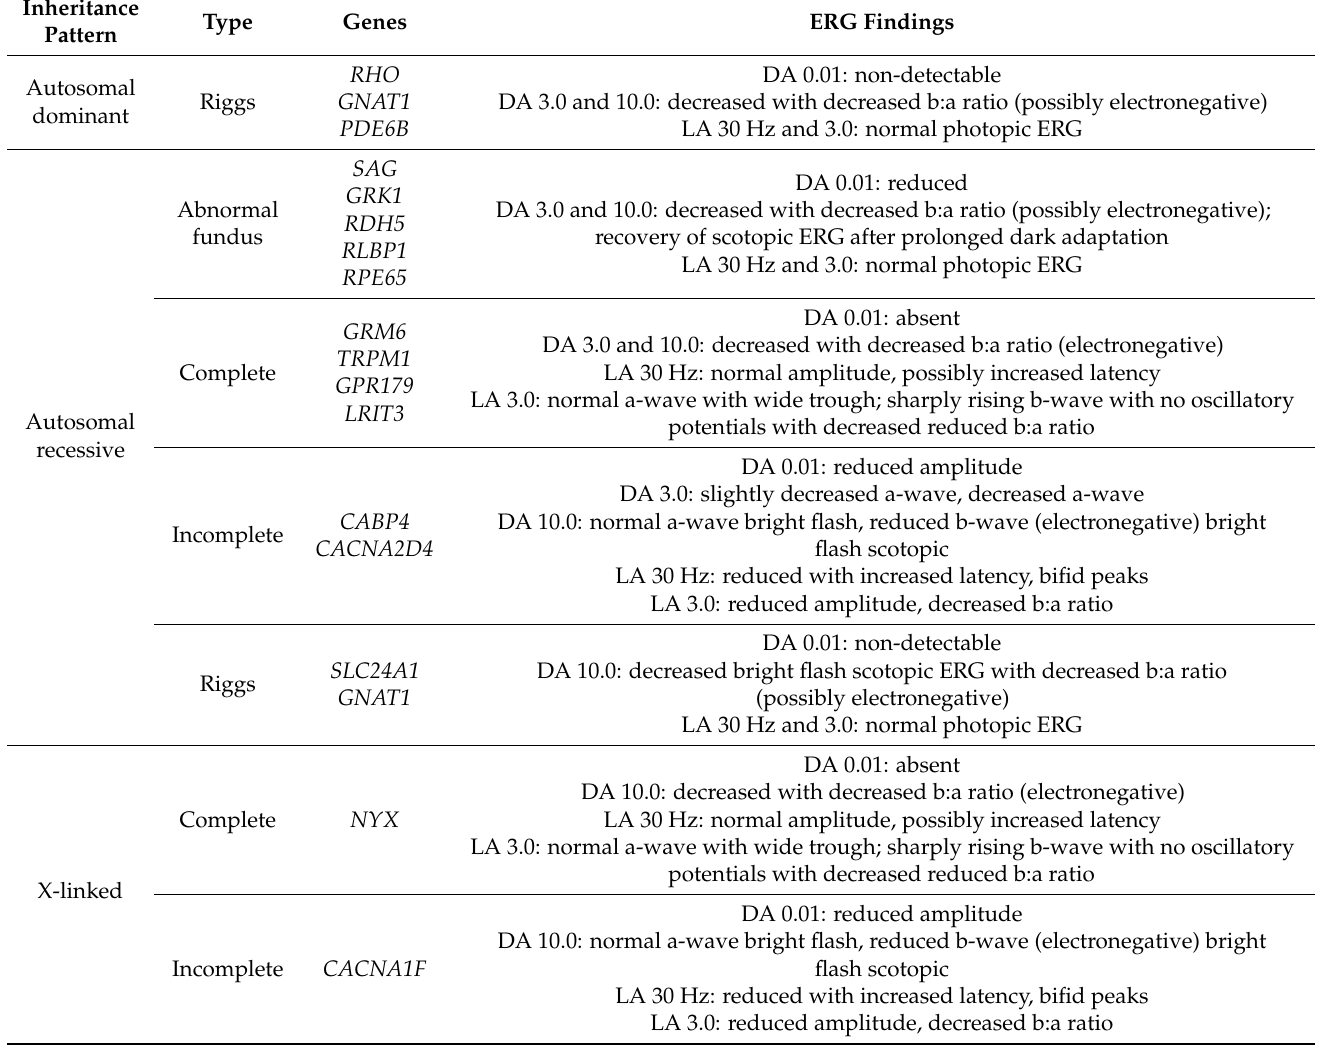
Table 1. Summary of congenital stationary night blindness (CSNB) types, inheritance patterns, and electroretinogram